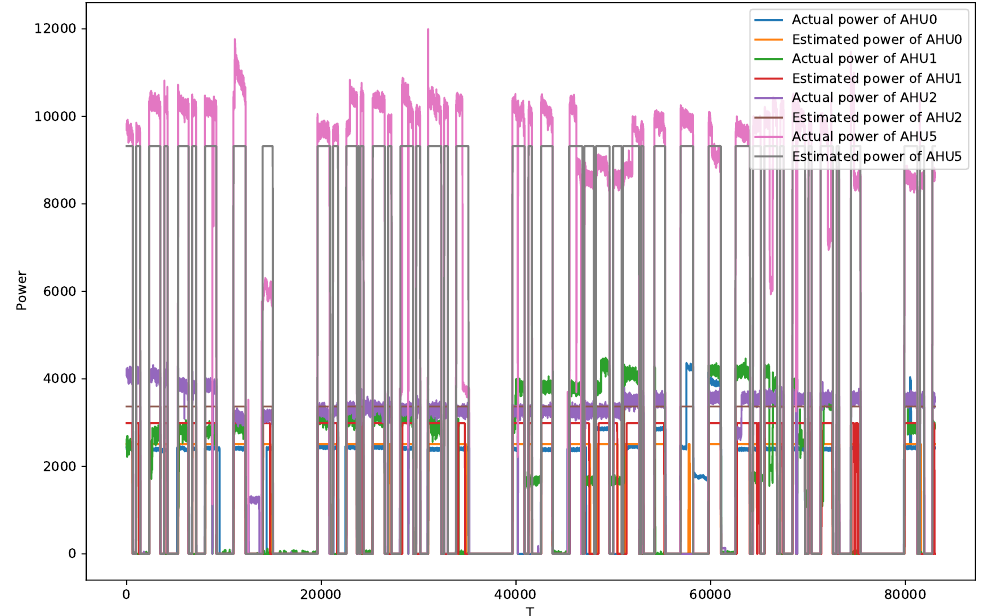
Figure 7. Comparison of the instantaneous power estimates and the actual power in the unseen scenario.